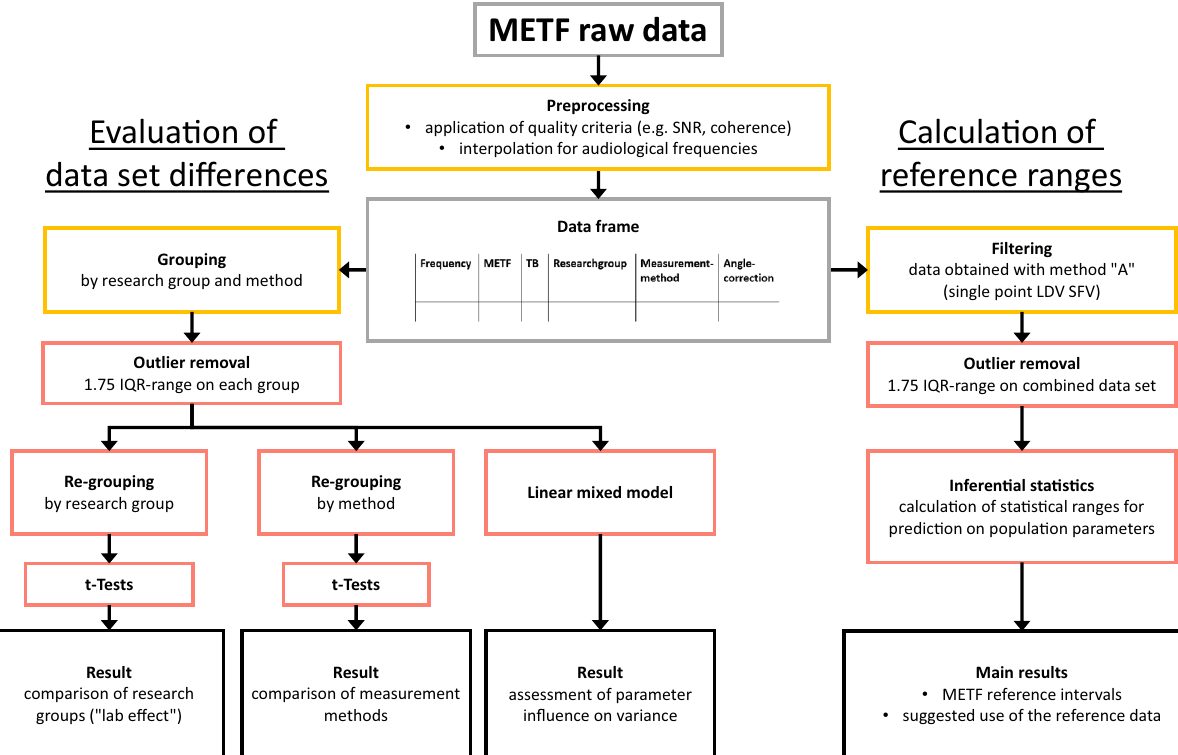
Figure 1. Outline of the study. Corresponding sections in the manuscript are color-coded: Yellow boxes (top) and red boxes (middle) refer to “Methods and Material”, subsections “Grouping and pre-processing of the data” and “Statistical Analysis”, respectively. Black boxes refer to “Results” and “Discussion”